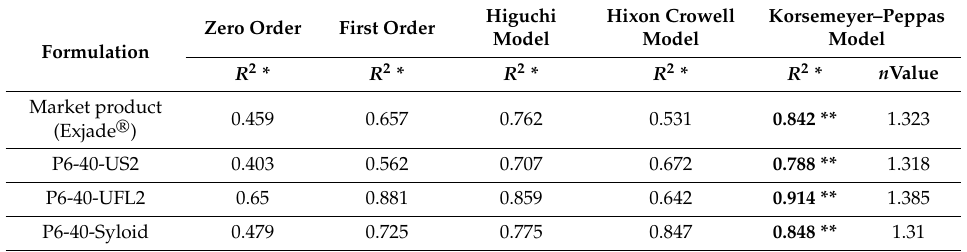
Table 7. The determination of coe ffi cient ( R 2 ) and release exponent ( n ) values for in vitro release profiles of the market product (Exjade ® ) and DFX S-SNEDD formulations prepared by di ff erent carriers. Zero Order First Formulation